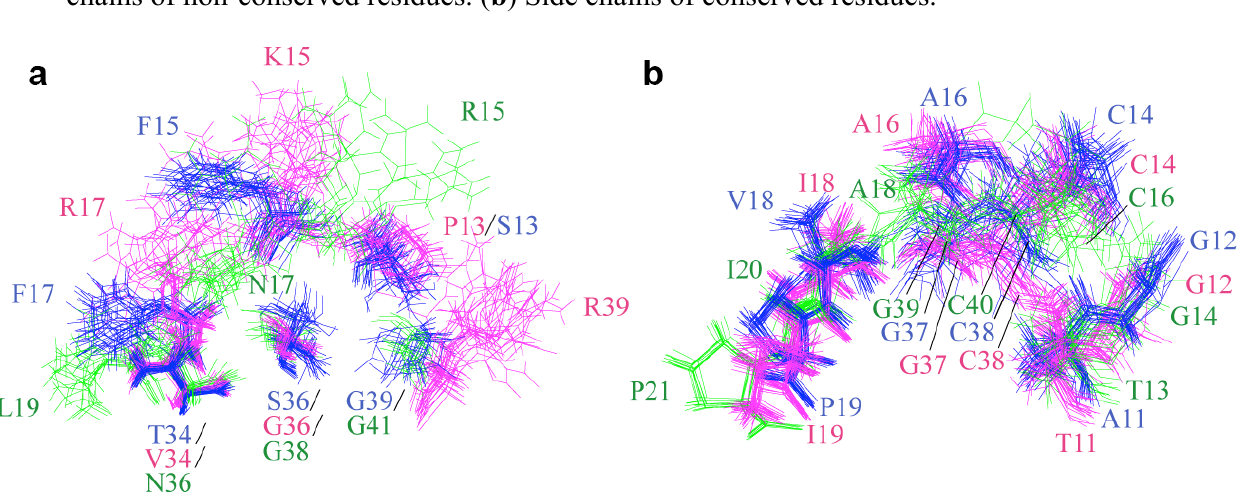
Figure 7. Side chains of residues 11–19, 34, and 36–39 in the trypsin binding loops of BPTI (magenta) and corresponding residues in NACI (blue) and BF9 (green). ( a ) Side chains of non-conserved residues. ( b ) Side chains of conserved